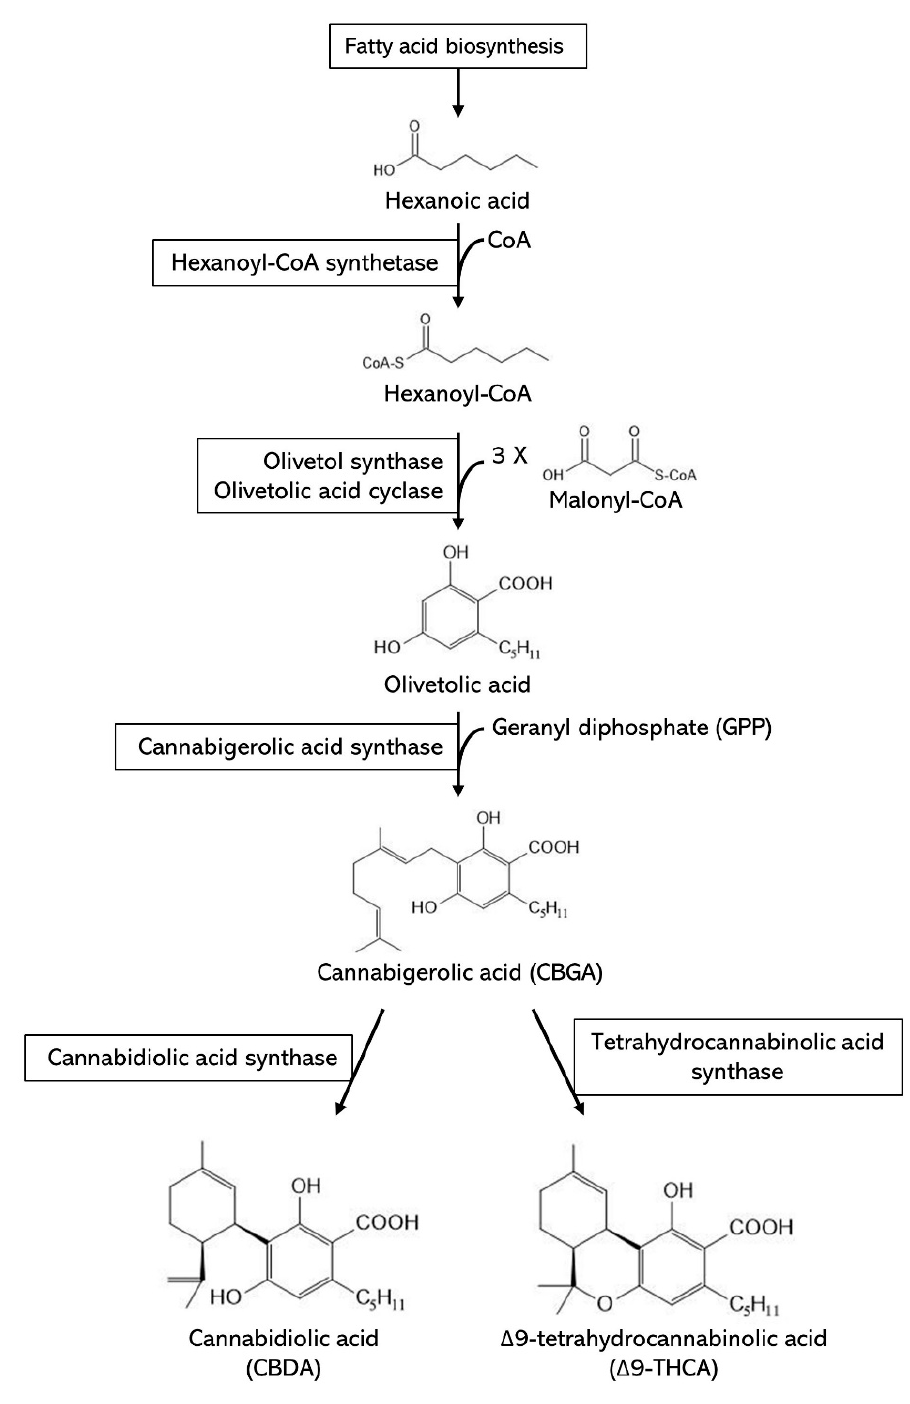
Figure 1. Cannabinoid synthesis pathway.